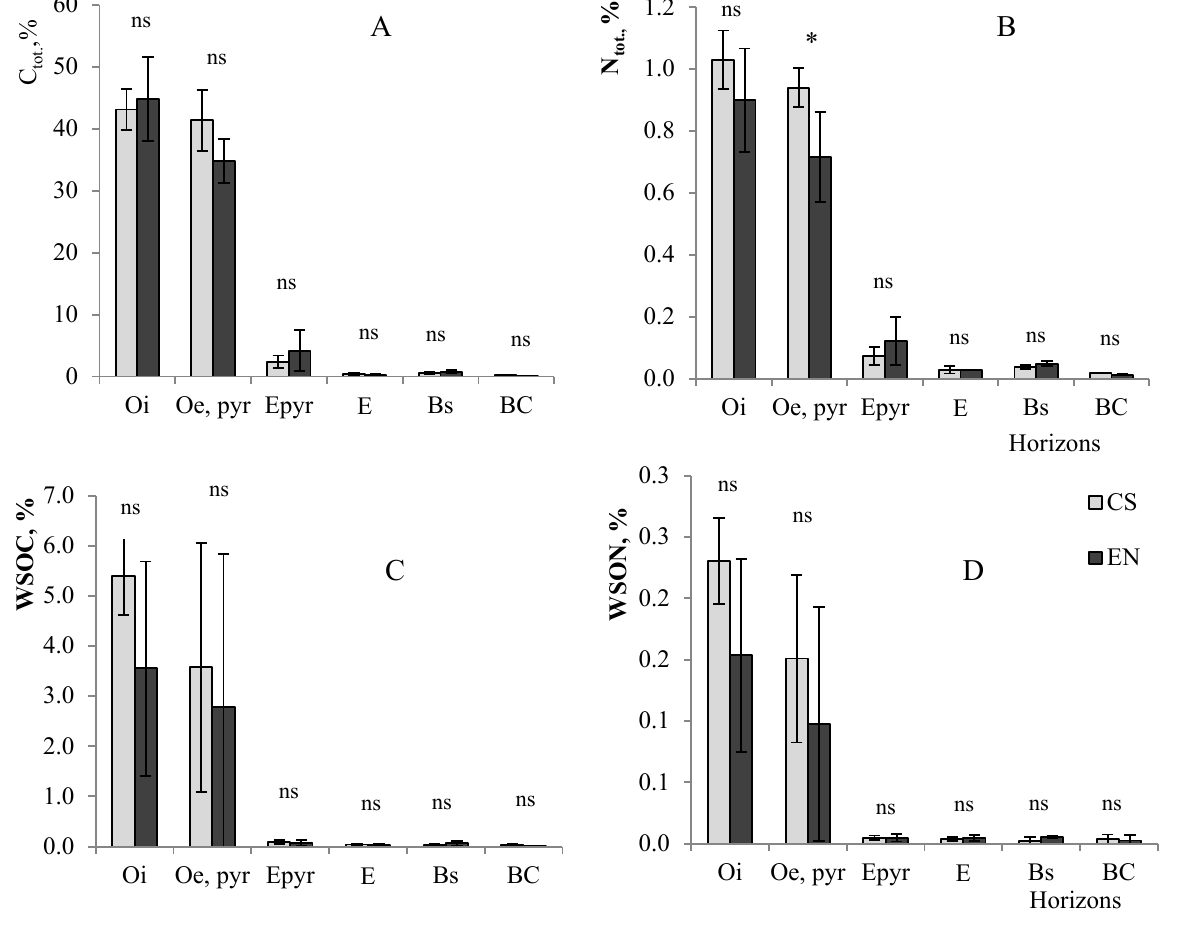
Figure 4. Carbon ( A ) and nitrogen ( B ), water-soluble carbon compound, ( C ) and water-soluble nitrogen compound ( D ) contents at horizons of studied soils ( n = 3, the error bars are the standard errors). Abbreviation: CS—Central Siberia, EN—European North. *—indicate significant differences between EN and CS, ns—differences between EN and CS are not significant at p < 0.05.